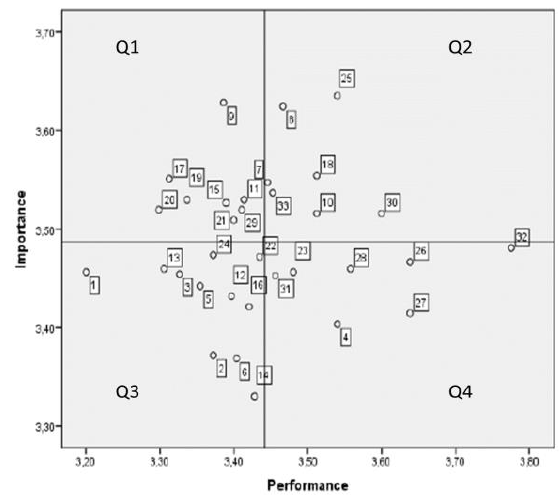
Figure 1: IPA output; Source: Own